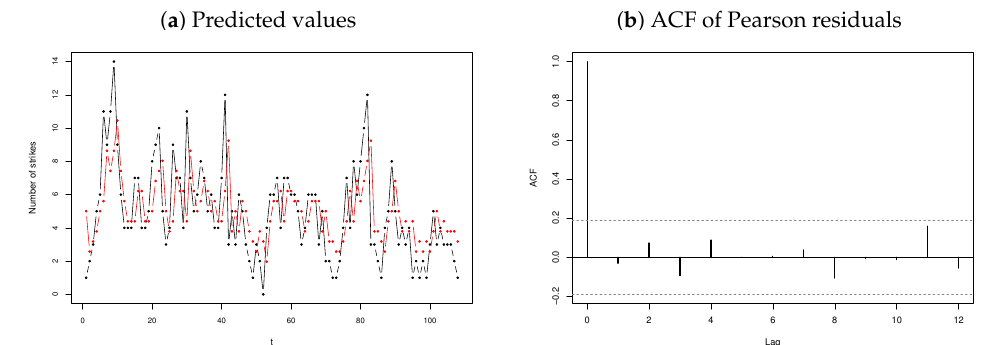
Figure 13. Predicted values (in red) and ACF of the Pearson residuals for the strike